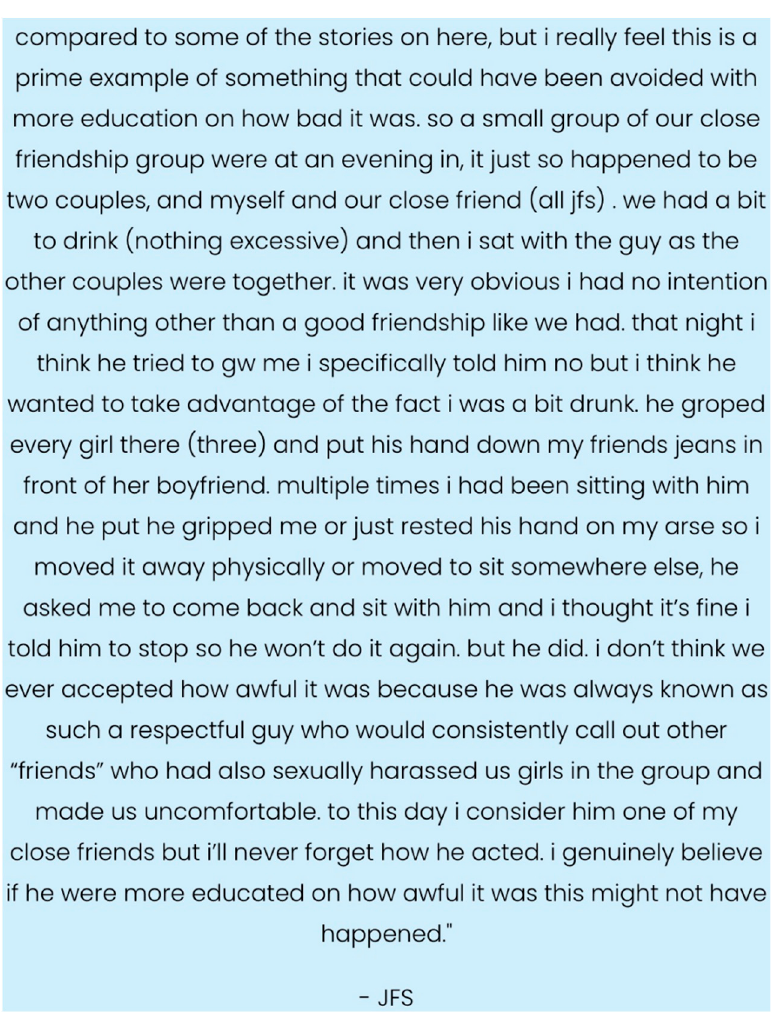
Figure 3. Digital testimony submitted to Everyone’s Invited.